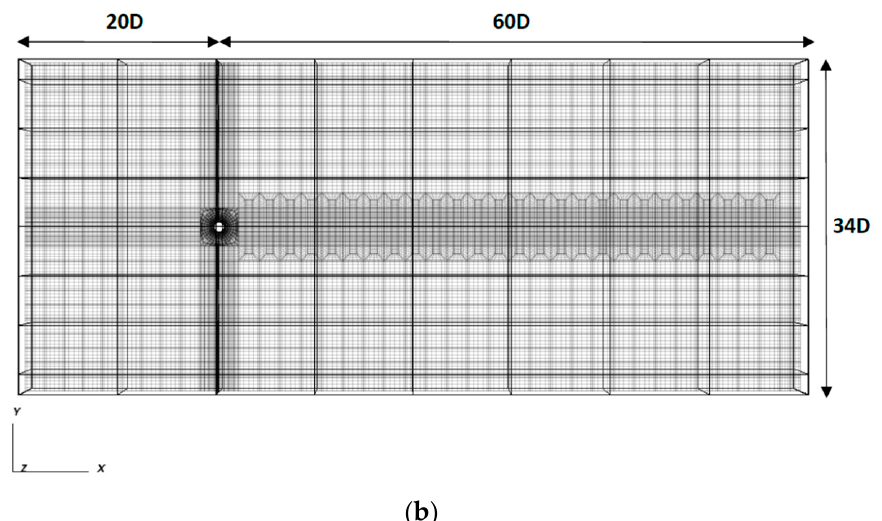
Figure 1. ( a ) Sketch of cylinder oscillation with respect to a uniform stream: ( a.a ) counter-clockwise mode, ( a . b ) clockwise mode. ( b ) Spectral element grid for three-dimensional flow past a circular cylinder. The origin of axes is at the cylinder center.